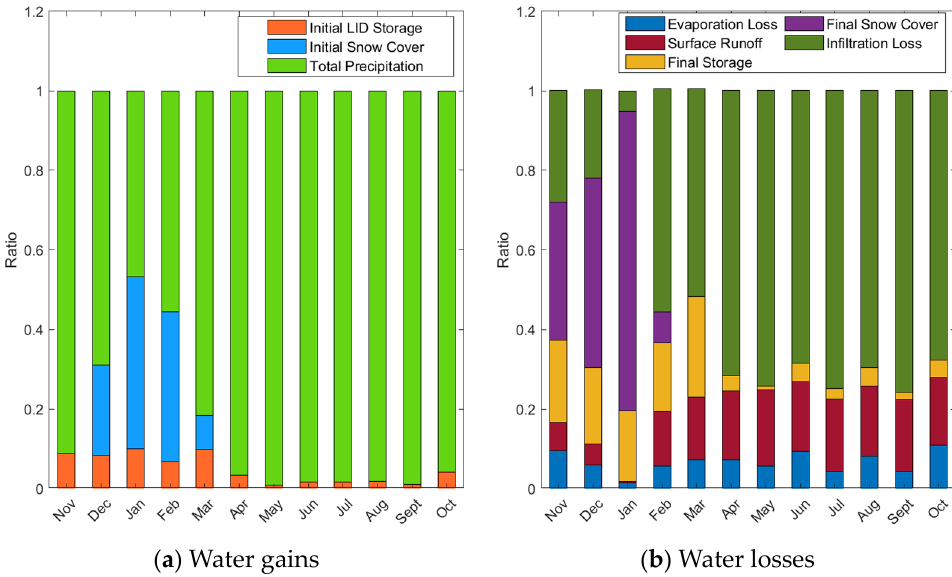
Figure 10. Monthly water gains ( a ) and losses ( b ) in the LID scenario.